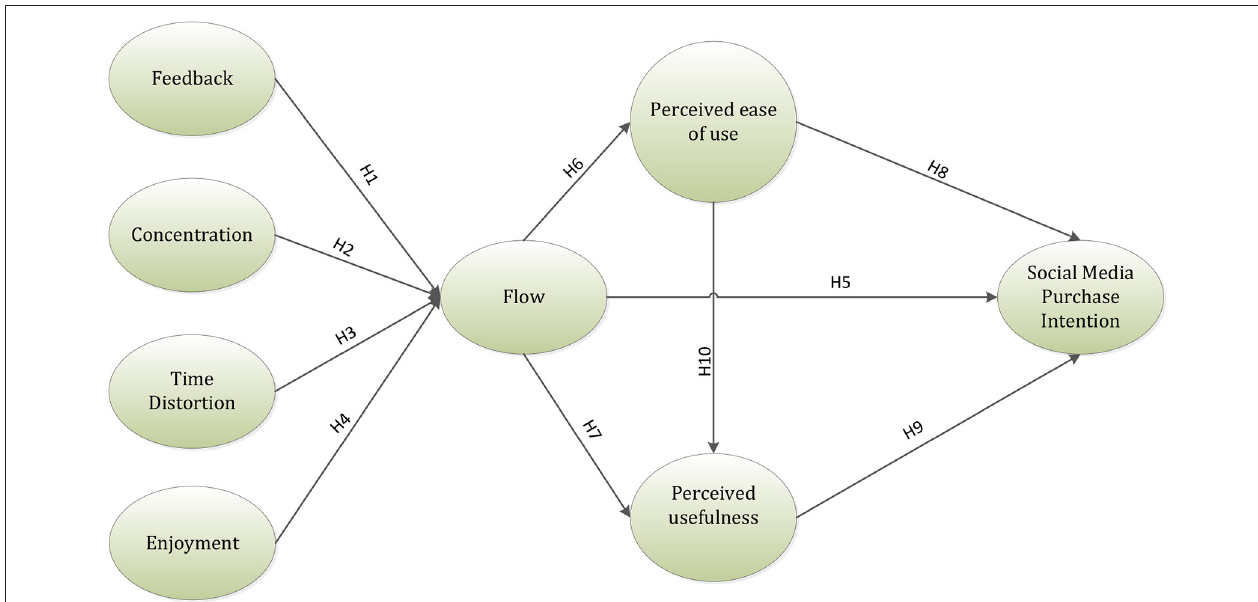
FIGURE 1 | Research